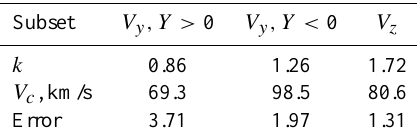
Table 2. Results of the kappa distribution fit